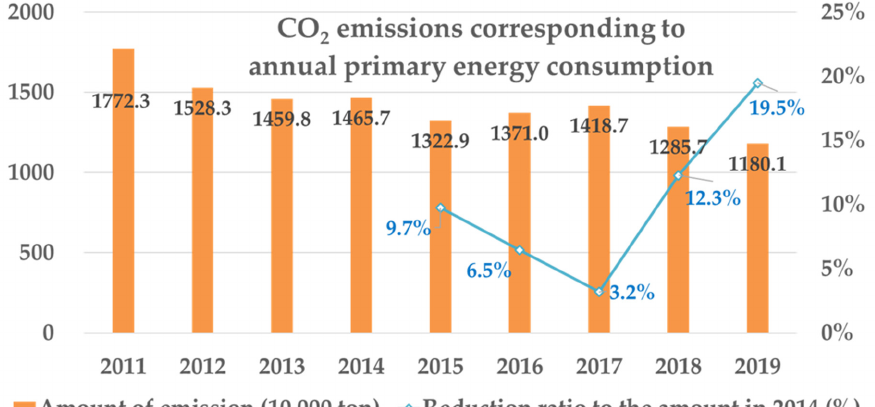
Figure 12. Annual CO 2 emissions in relation to primary energy consumption in secondary industries of Shenzhen from 2011 to 2019 (consumption of coal is estimated by identifying the parts of the Shenzhen–Shanwei Special Cooperation Zone, in which the coal consumption was added to the Shenzhen Yearbook since